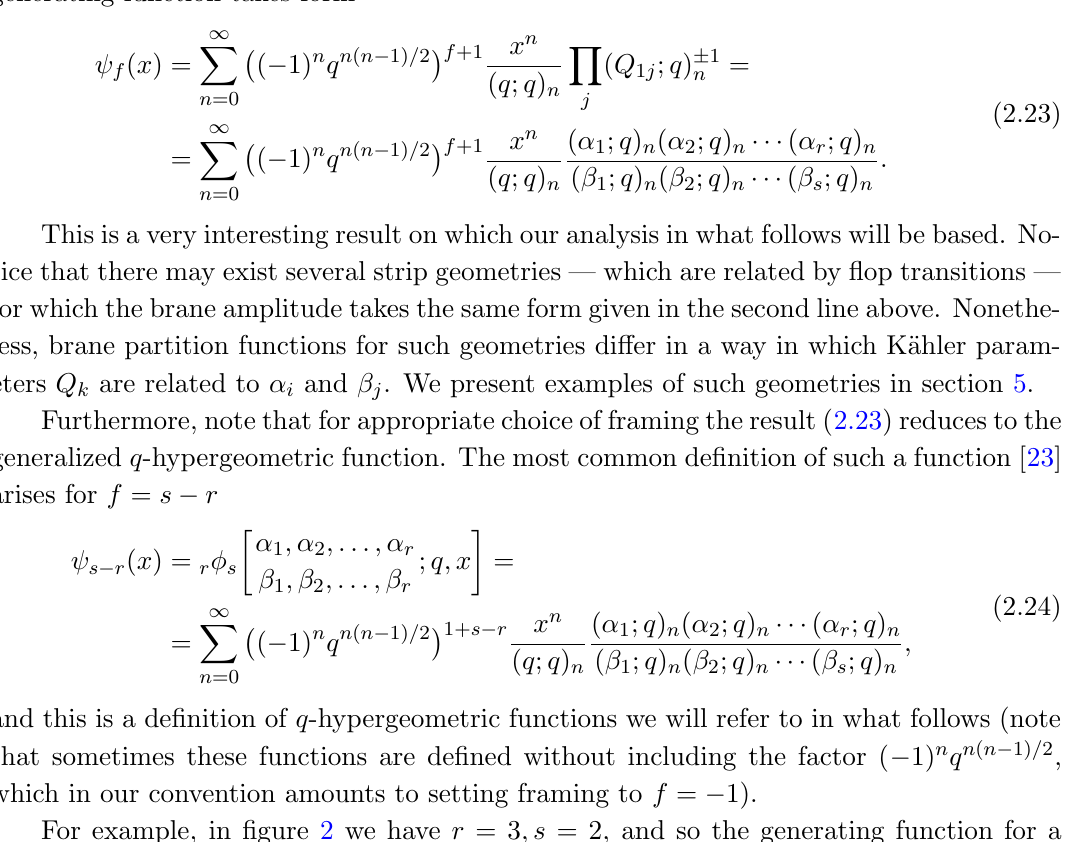
Figure 2 . A strip geometry with a single brane at the (cid:12)rst vertex. The brane modulus is denoted by x , and internal segments represent P 1 ’s with K(cid:127)ahler parameters Q k . generating function takes